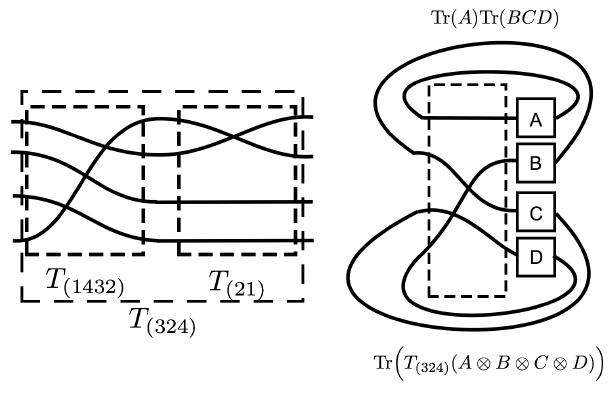
Figure 12: Graphical representation of the swap operator algebra and how the traces